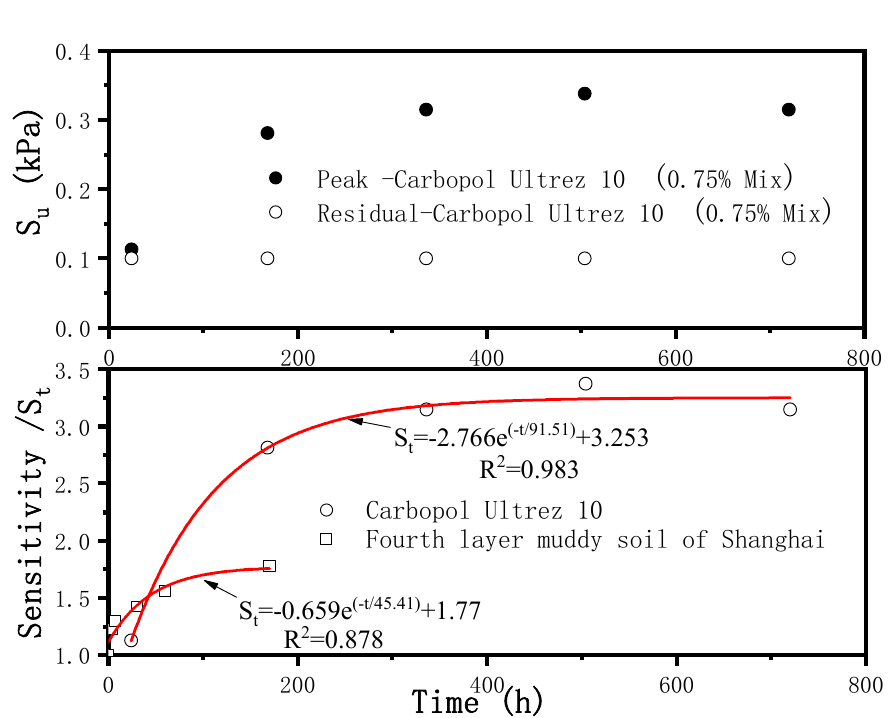
Figure 10. Sensitivity measured by the laboratory vane shear test: peak and residual strength, and sensitivity versus time.